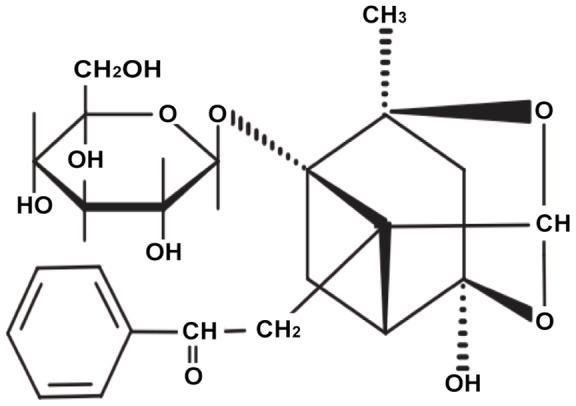
Chemical structure of paeoniflorin.